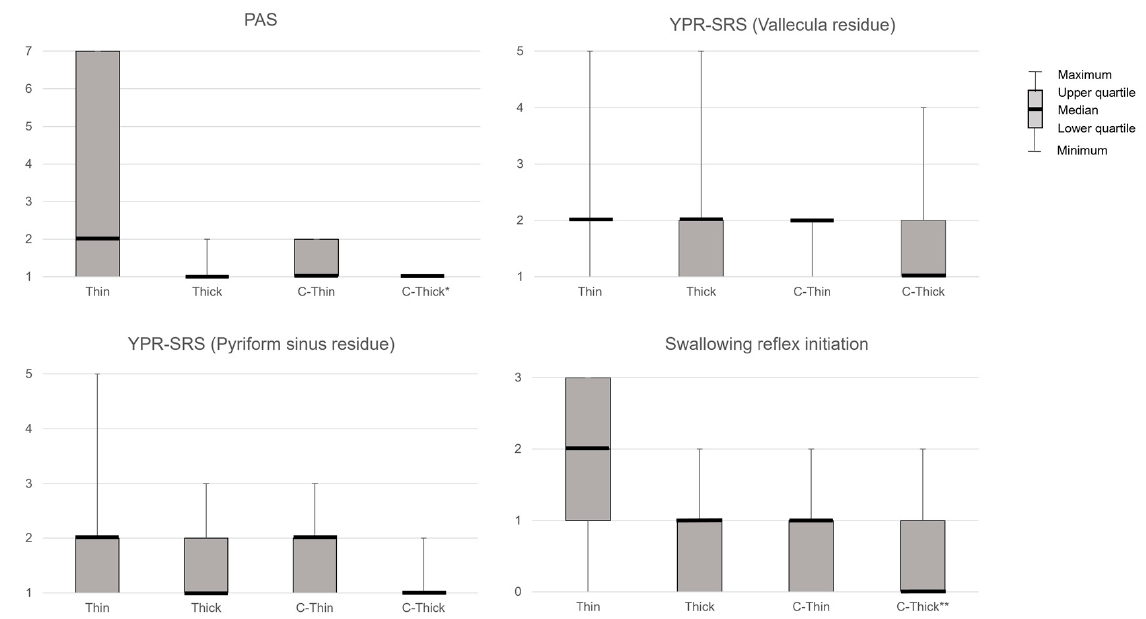
Figure 2. FEES results for each liquid. PAS, Penetration–Aspiration Scale; YPR-SRS, Yale Pharyngeal Residue Severity Rating Scale; Thin, thin liquid; Thick, thickened liquid; C-Thin, carbonated thin drink; C-thick, carbonated thickened drink. *, p < 0.05 (vs. Thin); **, p < 0.01 (vs. Thin).